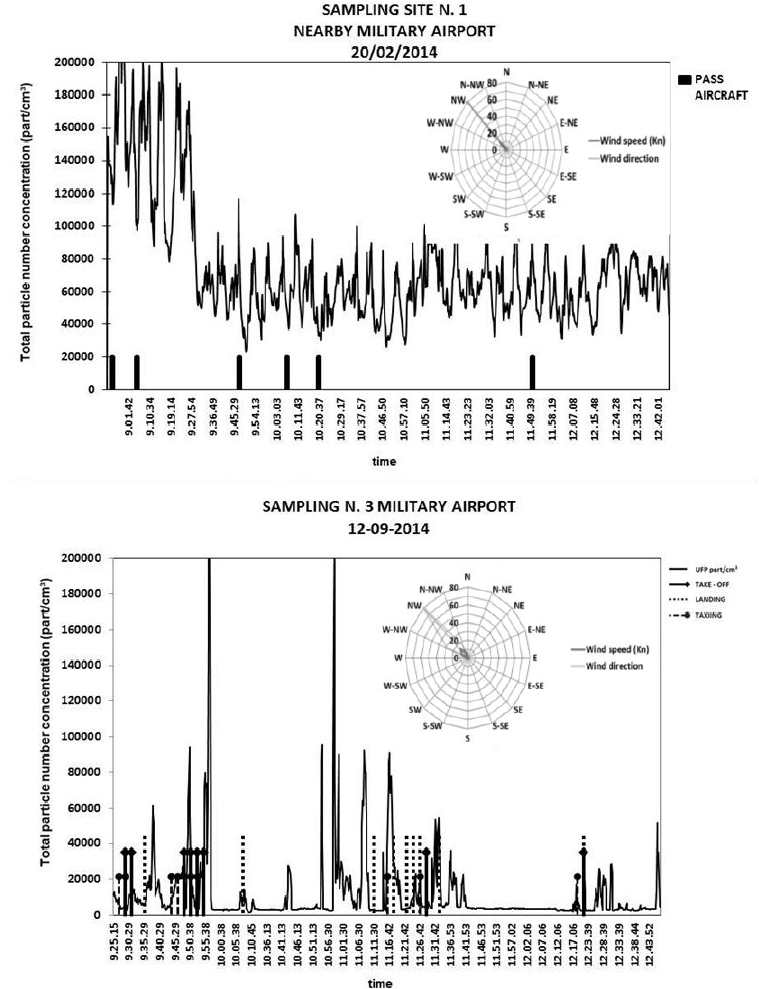
Figure 4. UFP count (range, median, and interquartile range) during flight activities inside the military airport (all sampling sites combined).